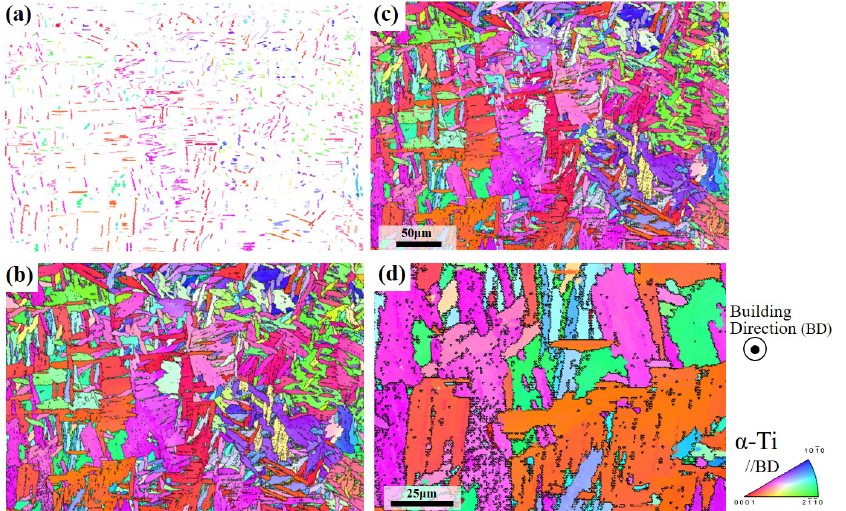
Figure 13. ( a ) Inverse pole figure of α phase at 950 ◦ C. ( b ) Inverse pole figure of α and β phases at 20 ◦ C with black line of the grain boundaries , ( c ) superimposed map of ( a , b , d ) enlarged view of ( c ). The black lines in the inverse pole figure indicate the grain boundaries with the misorientation angle of 5 ◦ or